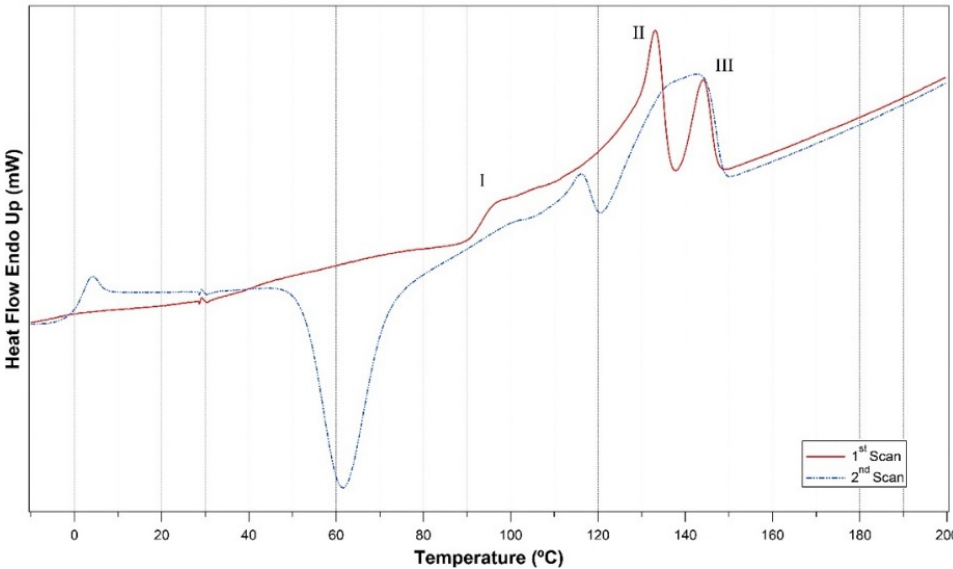
Figure 2. DSC curves of the first and second heating cycles of P − 0.